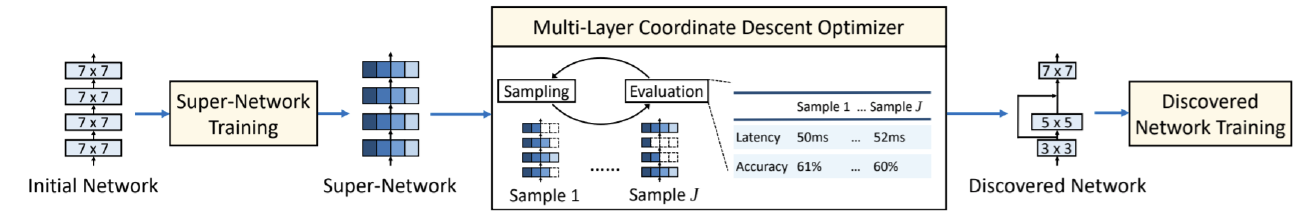
Figure 7. The algorithm flow of NAS in NetAdaptV2. (Reprinted from ref.